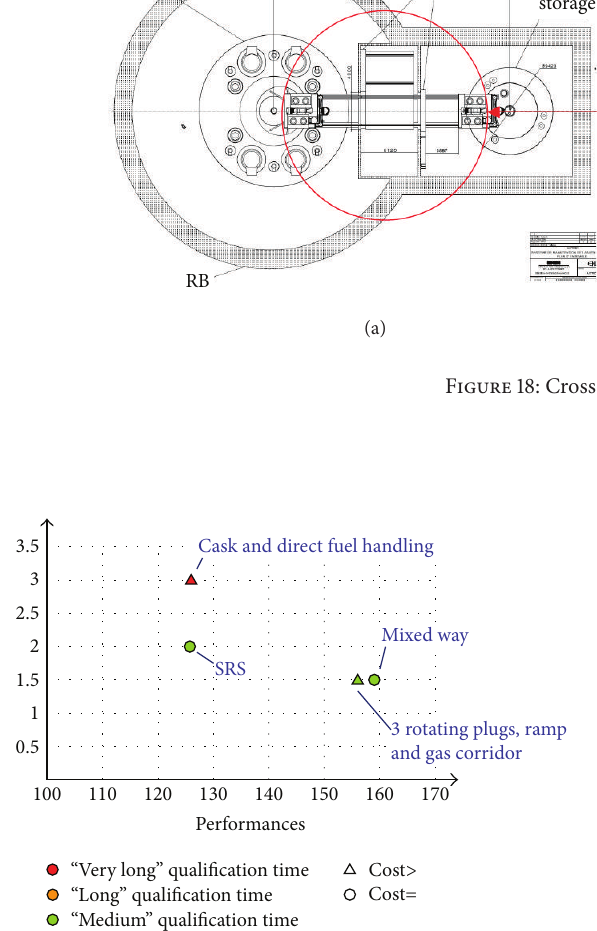
increased primary vessel diameter, and the extra cost related to complex mechanisms integrated into the